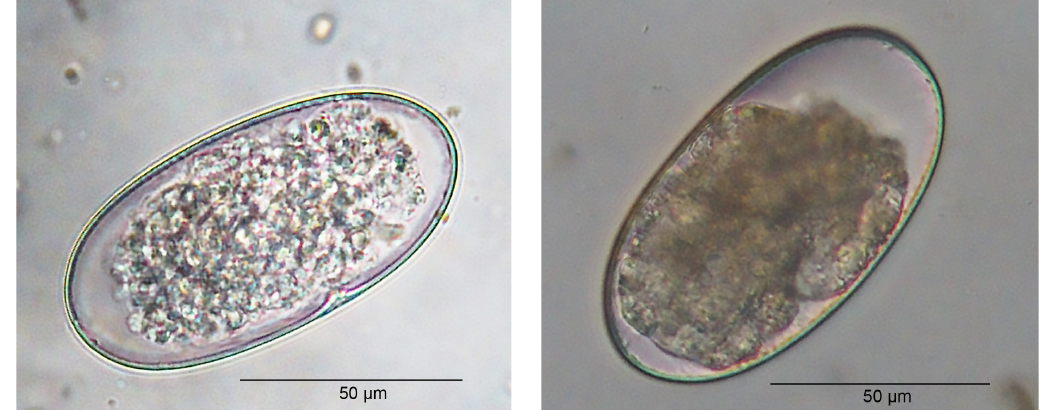
Figure 2. Nomarski interference contrast photomicrographs of two strongyle type nematode eggs from feces of Amer- alik caribou calves (mixed native caribou and semi-domestic Norwegian reindeer) of West Greenland. The symmetri- cal ellipse eggs have somewhat barrel-shaped side walls between two rounded poles. The thin chitinous shell is smooth surfaced. A large number of hardly distinguishable blastomeres occupy the entire decomposing eggs. Bar = 50 µm.